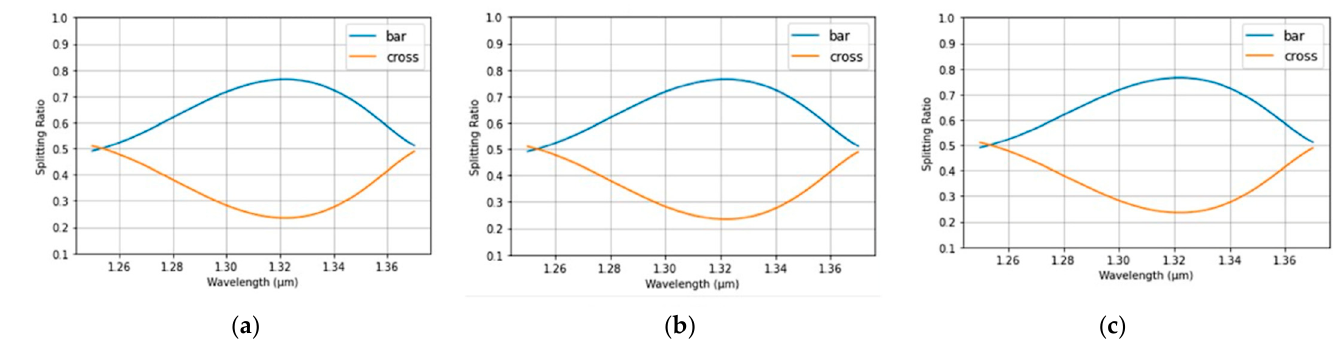
Figure 7. The simulated spectrum response for the bidirectional MZDC is demonstrated in the fol- lowing situations: ( a ) without the waveguide width variation; ( b ) 10 nm width shift; ( c ) − 10 nm width shift.